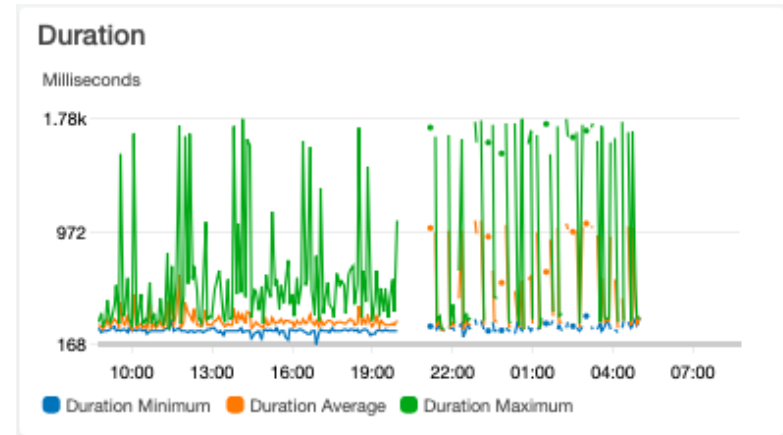
Figure 9. Intervals